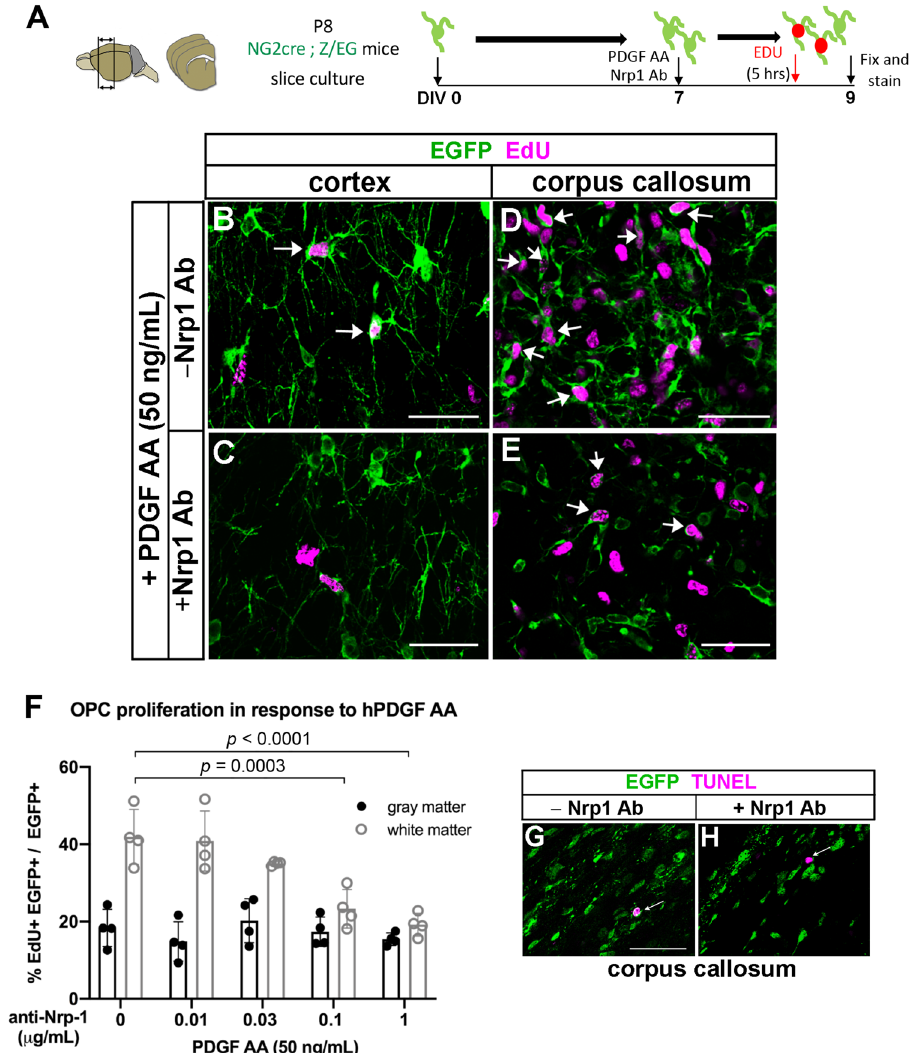
Fig. 1 Anti-Nrp1 antibody blocks PDGF AA-mediated OPC proliferation in white but not gray matter. A Schematic showing slice cultures from P8 NG2cre;Z/EG mice to assay for OPC proliferation in response to 50 ng/mL PDGF AA and different concentrations of anti-Nrp1 antibody. B – E Slice cultures from P8 NG2cre;Z/EG mice that were fi xed and labeled for EGFP (green) and EdU (magenta) in the cortex ( B and C ) or corpus callosum ( D and E ) in the presence of 50 ng/mL PDGF AA in the absence ( B and D ) or presence ( C and E ) of 1 µ g/mL anti-Nrp1 antibody. Arrows, examples of EGFP + EdU + cells. Scale bars, 50 µ m. F Quanti fi cation of OPC proliferation in slice cultures after 5 h of EdU labeling. y -axis, proportion of EGFP + cells that were EdU + . Tukey ’ s multiple comparisons test, n = 4, F (4, 30) = 9.966, means± standard deviations. The differences between OPC proliferation in gray and white matter were signi fi cant at anti-Nrp1 antibody concentrations of 0 ( p < 0.0001) and 0.01 µ g/mL ( p = 0.0065), but not at higher concentrations of the antibody. Black, gray matter; gray, white matter. Two-way ANOVA, Tukey ’ s multiple comparisons test, F (1, 30) = 89.71, n = 4. G , H Slice cultures treated with 1 µ g/mL control goat IgG ( G ) or goat anti-Nrp1 antibody ( H ) and labeled for EGFP (green) and TUNEL (magenta). Arrows indicate a TUNEL + cell. Scale bars, 50 µ m. Source data are provided as a Source Data fi